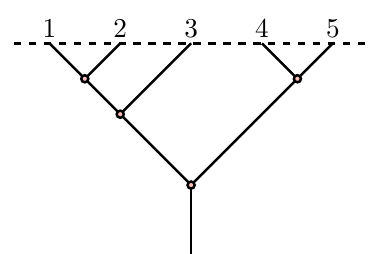
Figure 3 . Binary tree [[[1,2],3],[4,5]] for 5-points currents. One can understand the dashed line